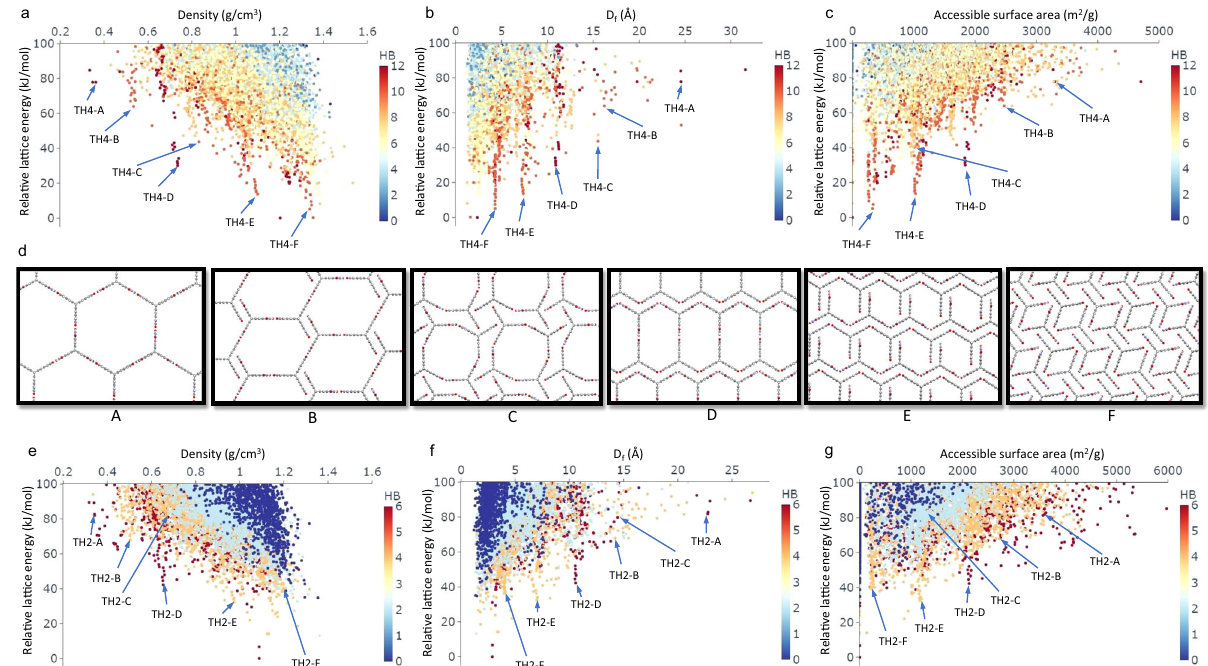
Fig. 3 ESF maps for individual structural descriptors. ESF maps for TH4 ( a – c ) and TH2 ( e – g ), plotted against the crystal density ( a , e ), the largest free sphere diameter ( D f ; b , f ) or the accessible surface area ( c , g ); symbols are colour coded by the number of hydrogen bonds formed by each molecule in the crystal structure. Selected TH4 ‘ landmark ’ structures A – F are displayed in ( d ) and labelled in ( a – c ), with their TH2 analogues labelled in ( e – g ).